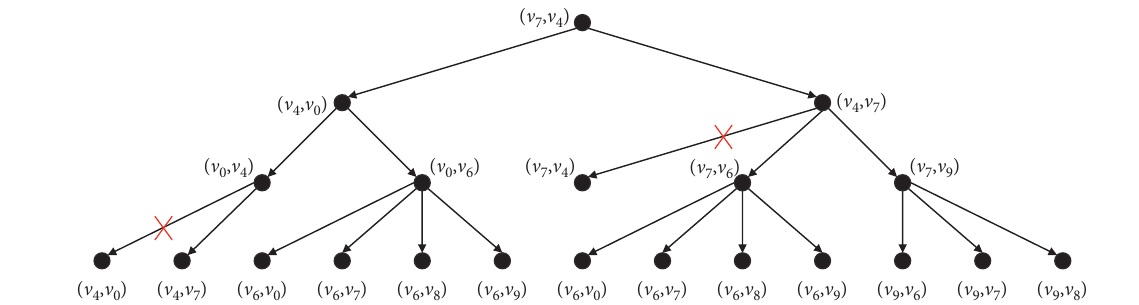
Figure 7: An example of the k -cycle pruning